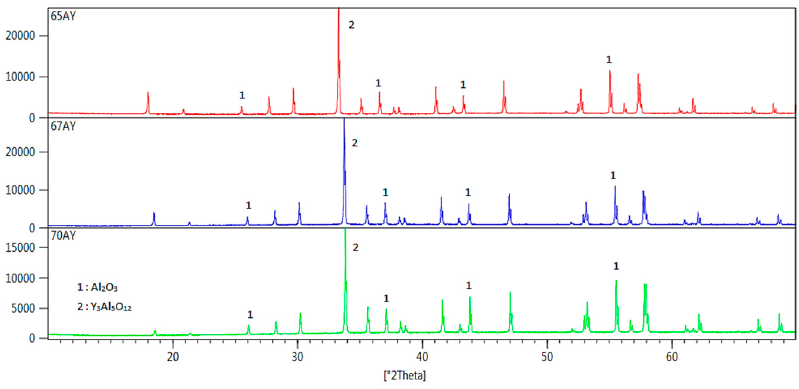
Figure 1. X-ray diffraction patterns of the sintered Al 2 O 3 -YAG samples obtained from different